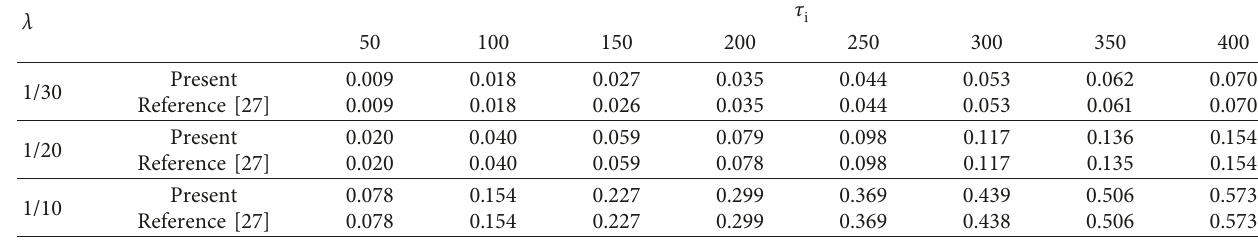
Table 2: Dimensionless displacement W ( f T 1). (cid:31)